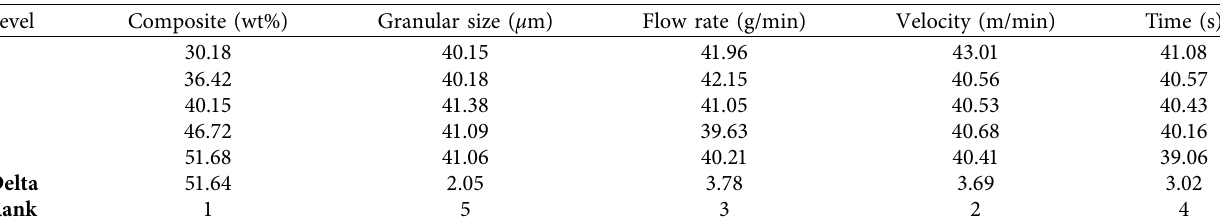
Table 8: S/N ratio’s response table (abrasive